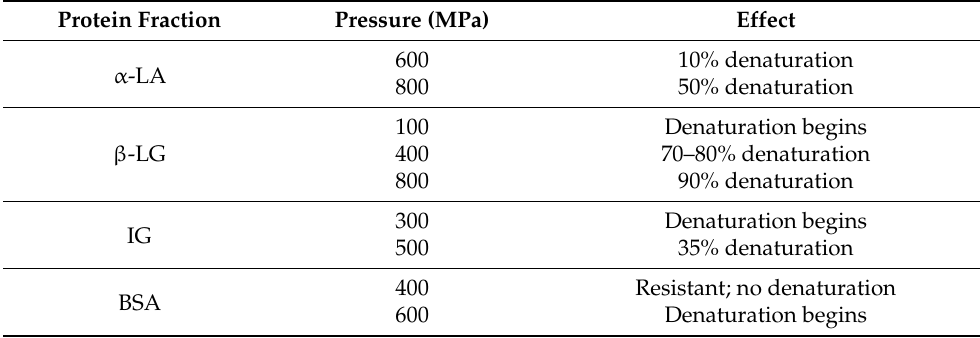
Table 3. Effects of different pressure intensities on whey proteins